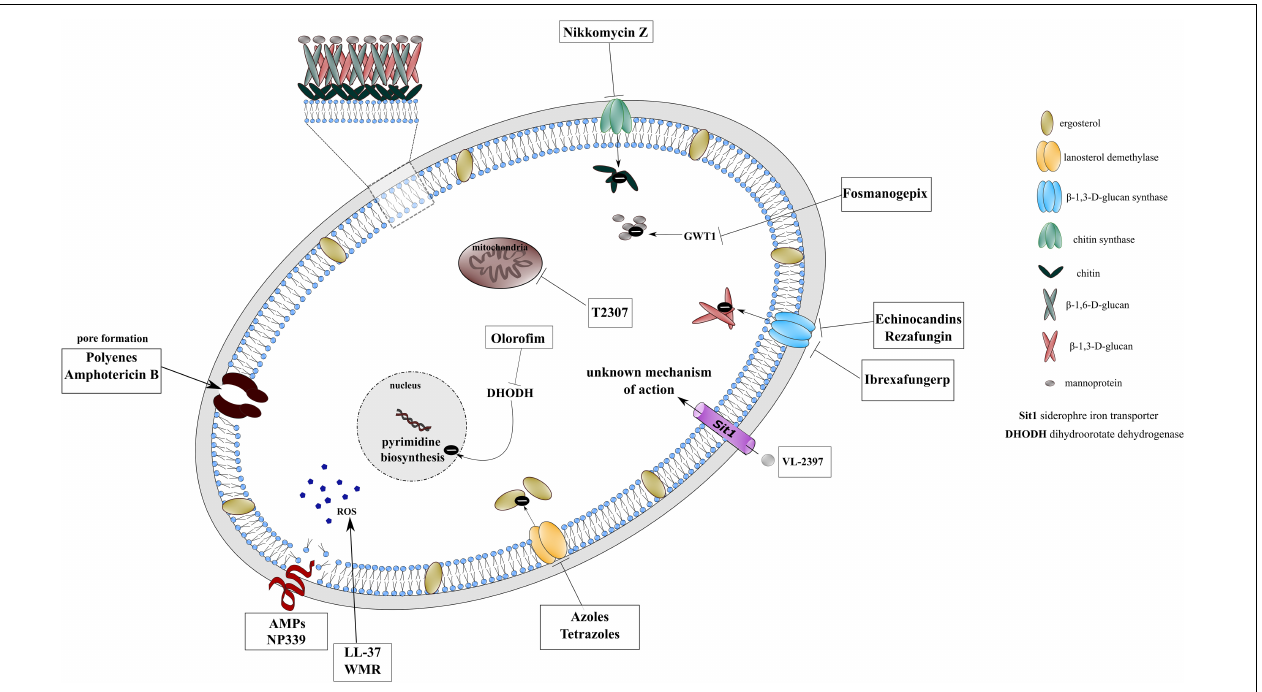
FIGURE 1 | Mechanism of action of conventional antifungal drugs, novel agents under development and potential antimicrobial candidates on cellular targets.